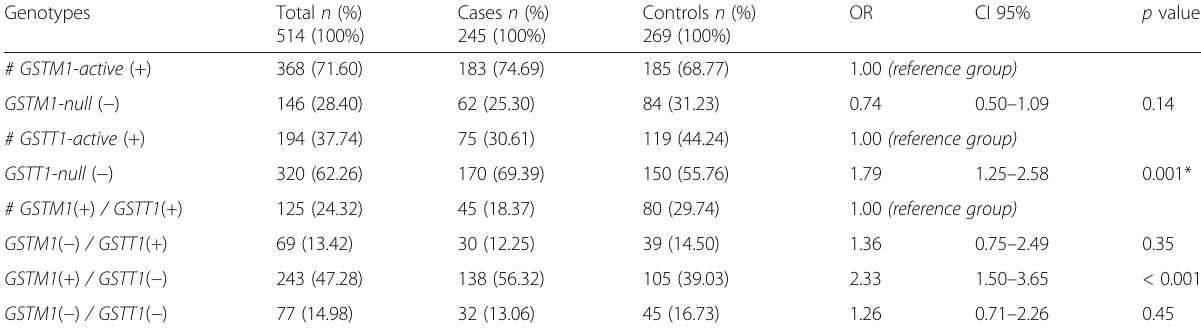
Table 2 Distribution of genotypic frequencies for GSTM1 and GSTT1 in the study population